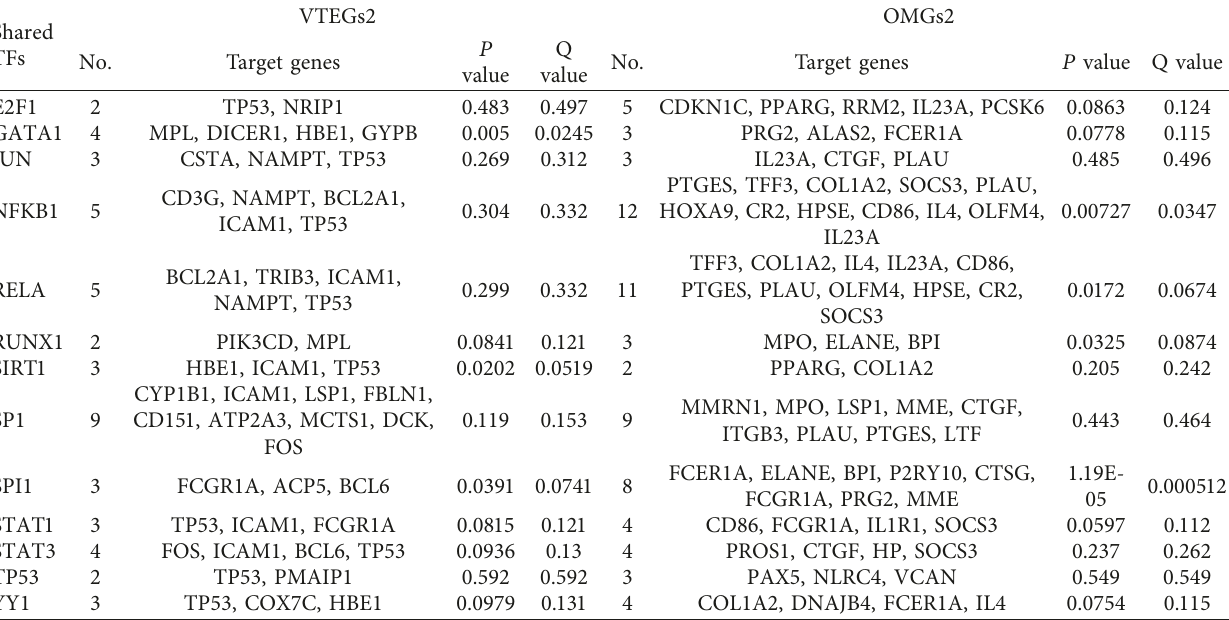
Figure 4: The DEGs2 enclosed by all sharing GO-BP terms. (a) A Venn plot of OMGs2 and VTEGs2. (b) PPI network of the shared DGEs2. (c) Fold change of the shared DGEs2. Table 2: The list of TF-target gene pairs of VTEGs2 and